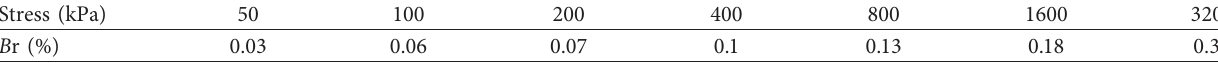
Table 3: Einav’s relative breakage of calcareous sand samples at each stress